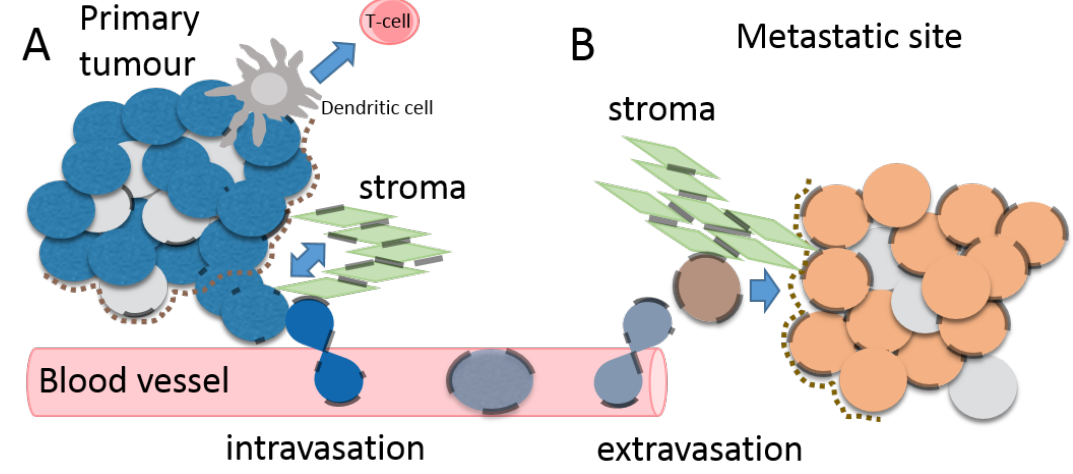
Figure 3. Gap-junctional intercellular communication in the tumour microenvironment and upon metastasis. ( A ) The tumour microenvironment consists of tumour cells (blue cells), non-tumour cells (light grey cells), immune cells including dendritic cells (dark grey cell) and CD8 + T-cells (pink cell), the basement membrane (brown dotted line) and the stroma (green cells). Tumour cells often display reduced gap junctions (transparent black lines) but can form heterotypic gap junctions with dendritic cells. Once they invade through to the stroma they can also form junctions with stromal cells. Upon intravasation into blood vessels tumour cells create gap junctions with endothelial cells lining the blood vessels; ( B ) Upon extravasation into a metastatic site, metastatic cells (orange cells) initiate gap-junctional intercellular communication with stromal cells and with other cells in the metastatic tumour microenvironment (light grey cells) and this may facilitate establishment of metastases. Depending on the site of metastasis, tumour cells may interact with cells of the immune system.